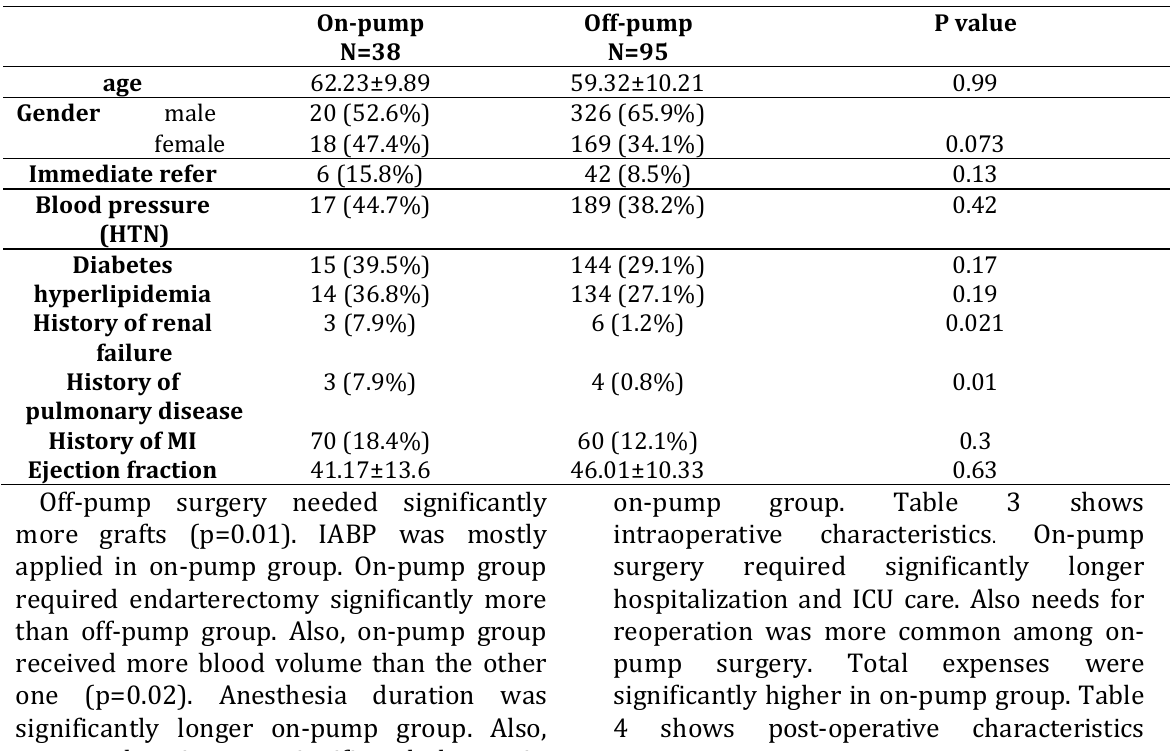
Table 2: Pre-operative